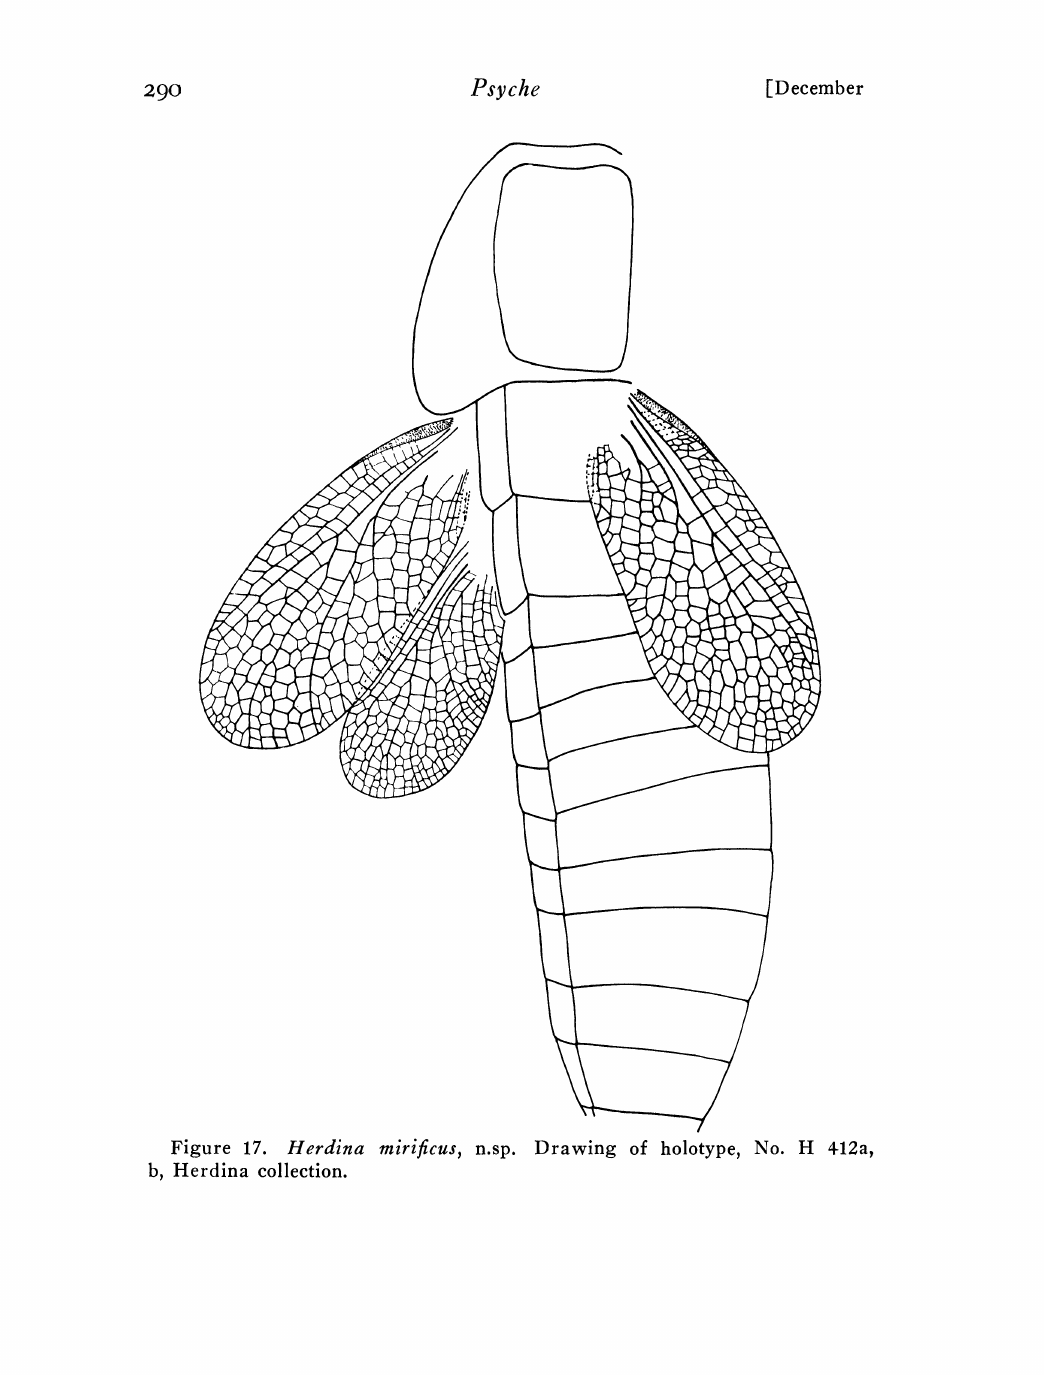
Figure 17. Herdina miri]icus, n.sp. Drawing of holotype, No. H 412a, b, Herdina